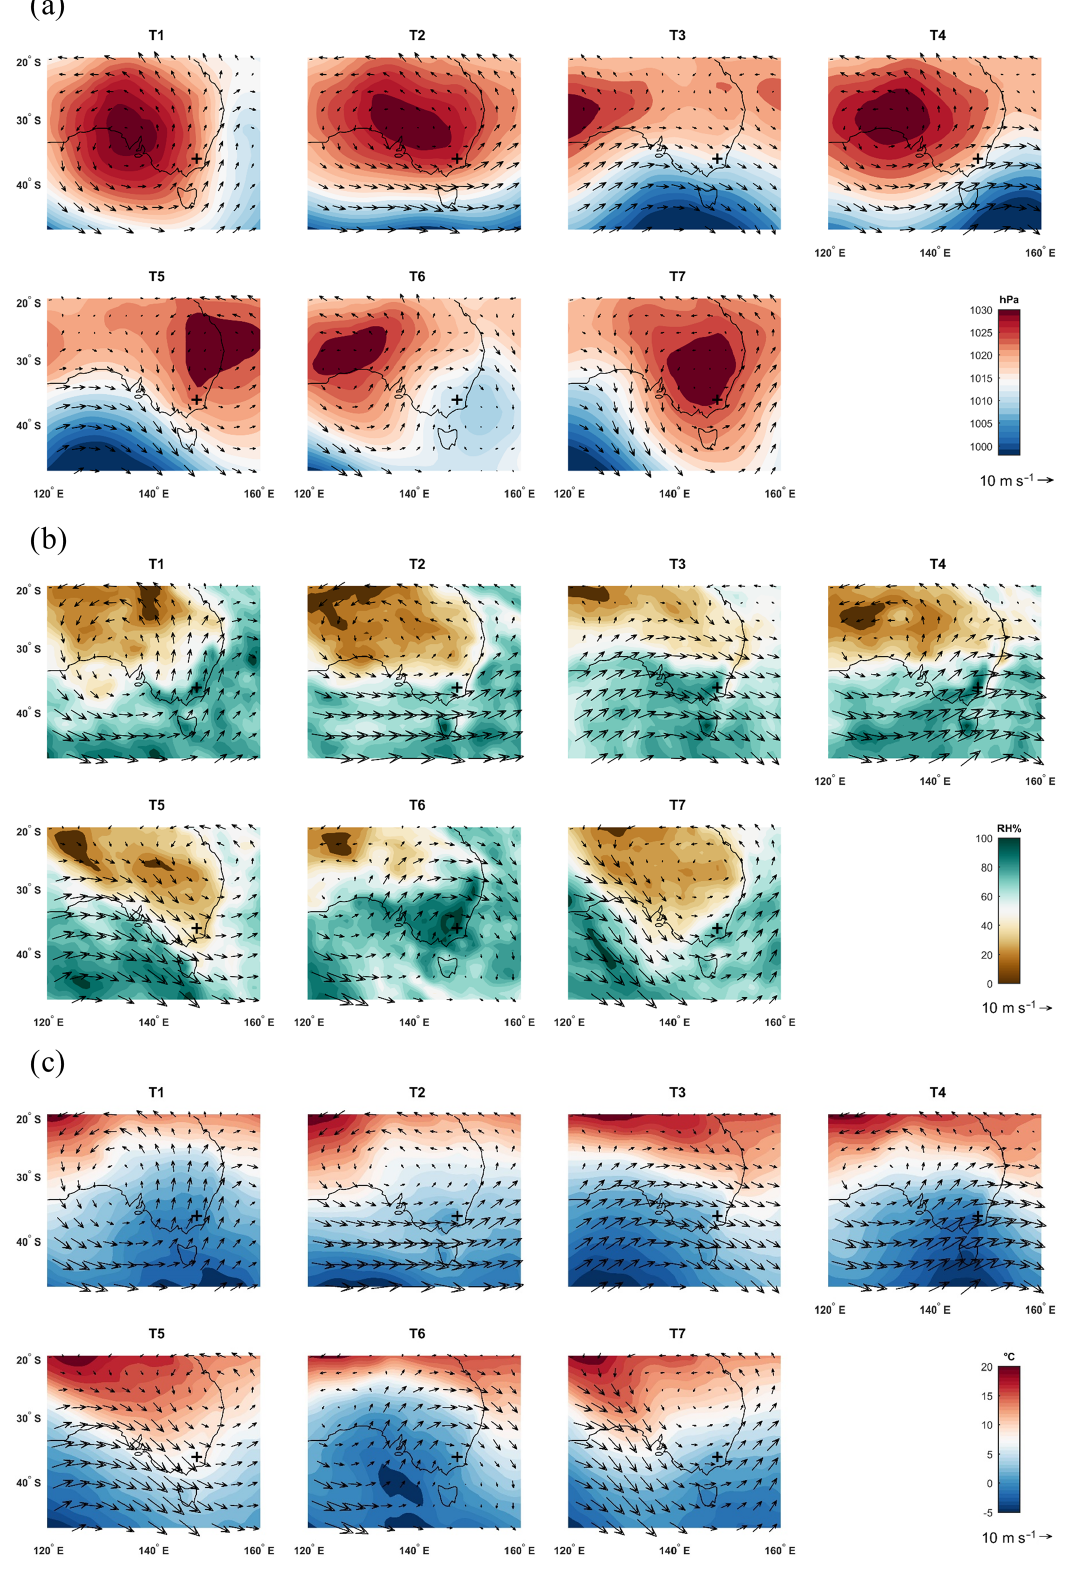
Figure 3. Mean synoptic type MSLP and 10m wind vectors (a) , 850hPa RH and wind vectors (b) , and 850hPa T d and wind vectors (c) over the southeast Australian region for the 2016 and 2017 seasons. The location of the surface energy balance site is marked with “ +